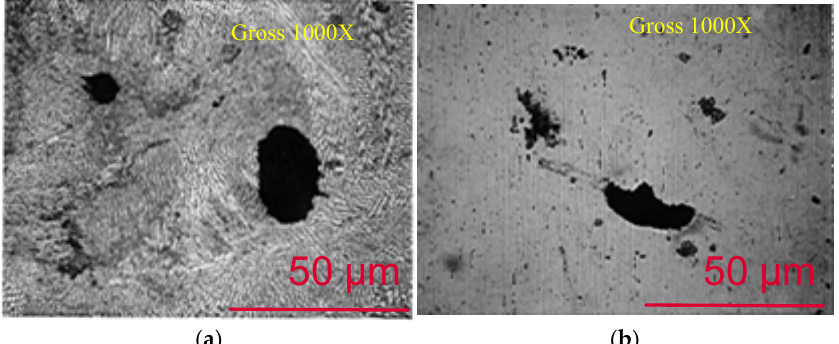
Figure 14. Pitting corrosion of the link/weld interface of the transversal surface in Test 2. Optical examination, magnification 40×. Sample #3.